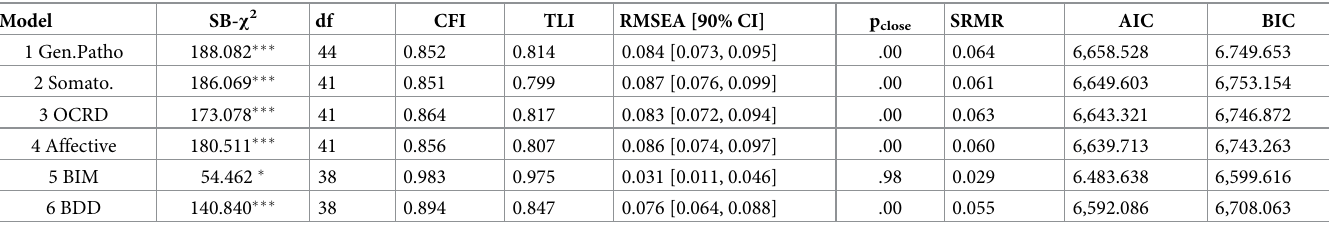
Table 6. SEM fit statistics for six competing models, restricted sample due to exclusion of primary shape and weight concerns.